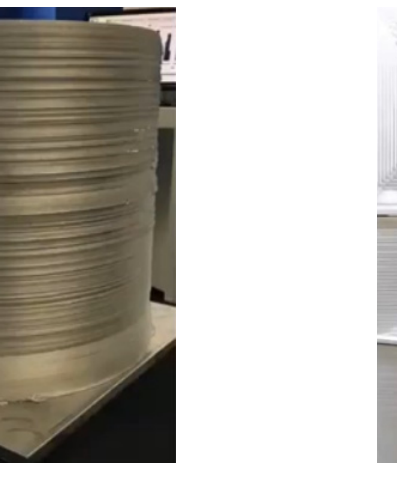
Figure 18. The possible repairing application of AFSD on the tank [62]. Another engineering application is the solid-state recycling of AFSD, as shown in Figure 19. Babaniaris et al. [37] consolidated the AA6063 swarf into rod feedstock via hot extrusion and then deposited the extruded rod by AFSD process. By the post-deposition heat treatment, the deposited AA6063 has wrought-like properties. Without consolida- tion, Jordan et al. [11] achieved the direct recycling of AA5083-H131 chips based on the AFSD process. Similar recycling was also achieved on Ti6Al4V chips. ( a ) ( b ) Figure 19. Different solid-state recycling processes. ( a ) Direct recycling of chips [11]. ( b ) Multi-step recycling of swarf [37]. Some researchers have explored the application of AFSD to surface coating. Gandra et al. [65] deposited the AA6082/SiC coating surface composite with a consumable rod. In